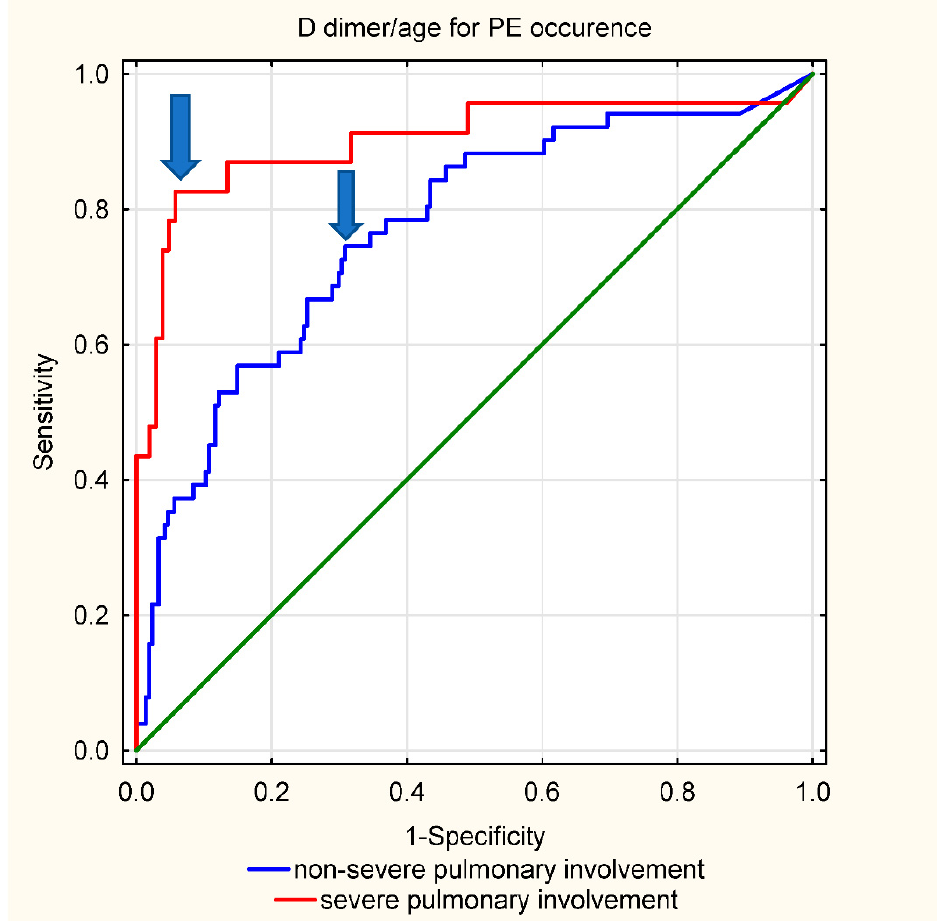
Figure 3. ROC curve for D-dimer/age ratio and occurrence of PE depending on the extent of pulmonary lesions, i.e., ≥ 50% or <50%. AUC for non-severe involvement = 0.769 (95% CI 0.694–0.845); AUC for severe involvement = 0.902 (95% CI 0.810–0.994), p = 0.029 for difference in AUC. The proposed thresholds are marked with arrows (D-dimer/age = 70, proposed for severe involvement, or D-dimer/age = 20 for non-severe involvement). The green line is the no-effect line.